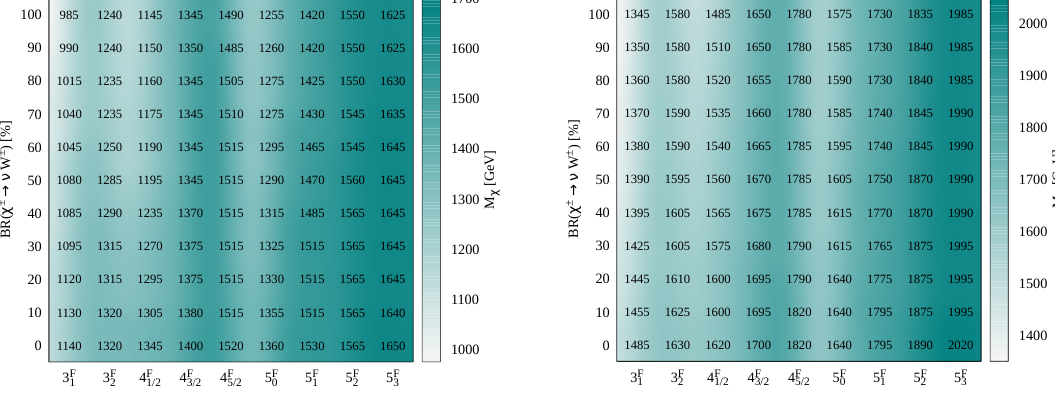
Figure 11 . 5 σ discovery reach of exotic leptons belonging to different simplified models for different values of BR ( χ ± → νW ± ) for 300 (left) and 3000 (right) fb − 1 luminosity of data at 13 TeV